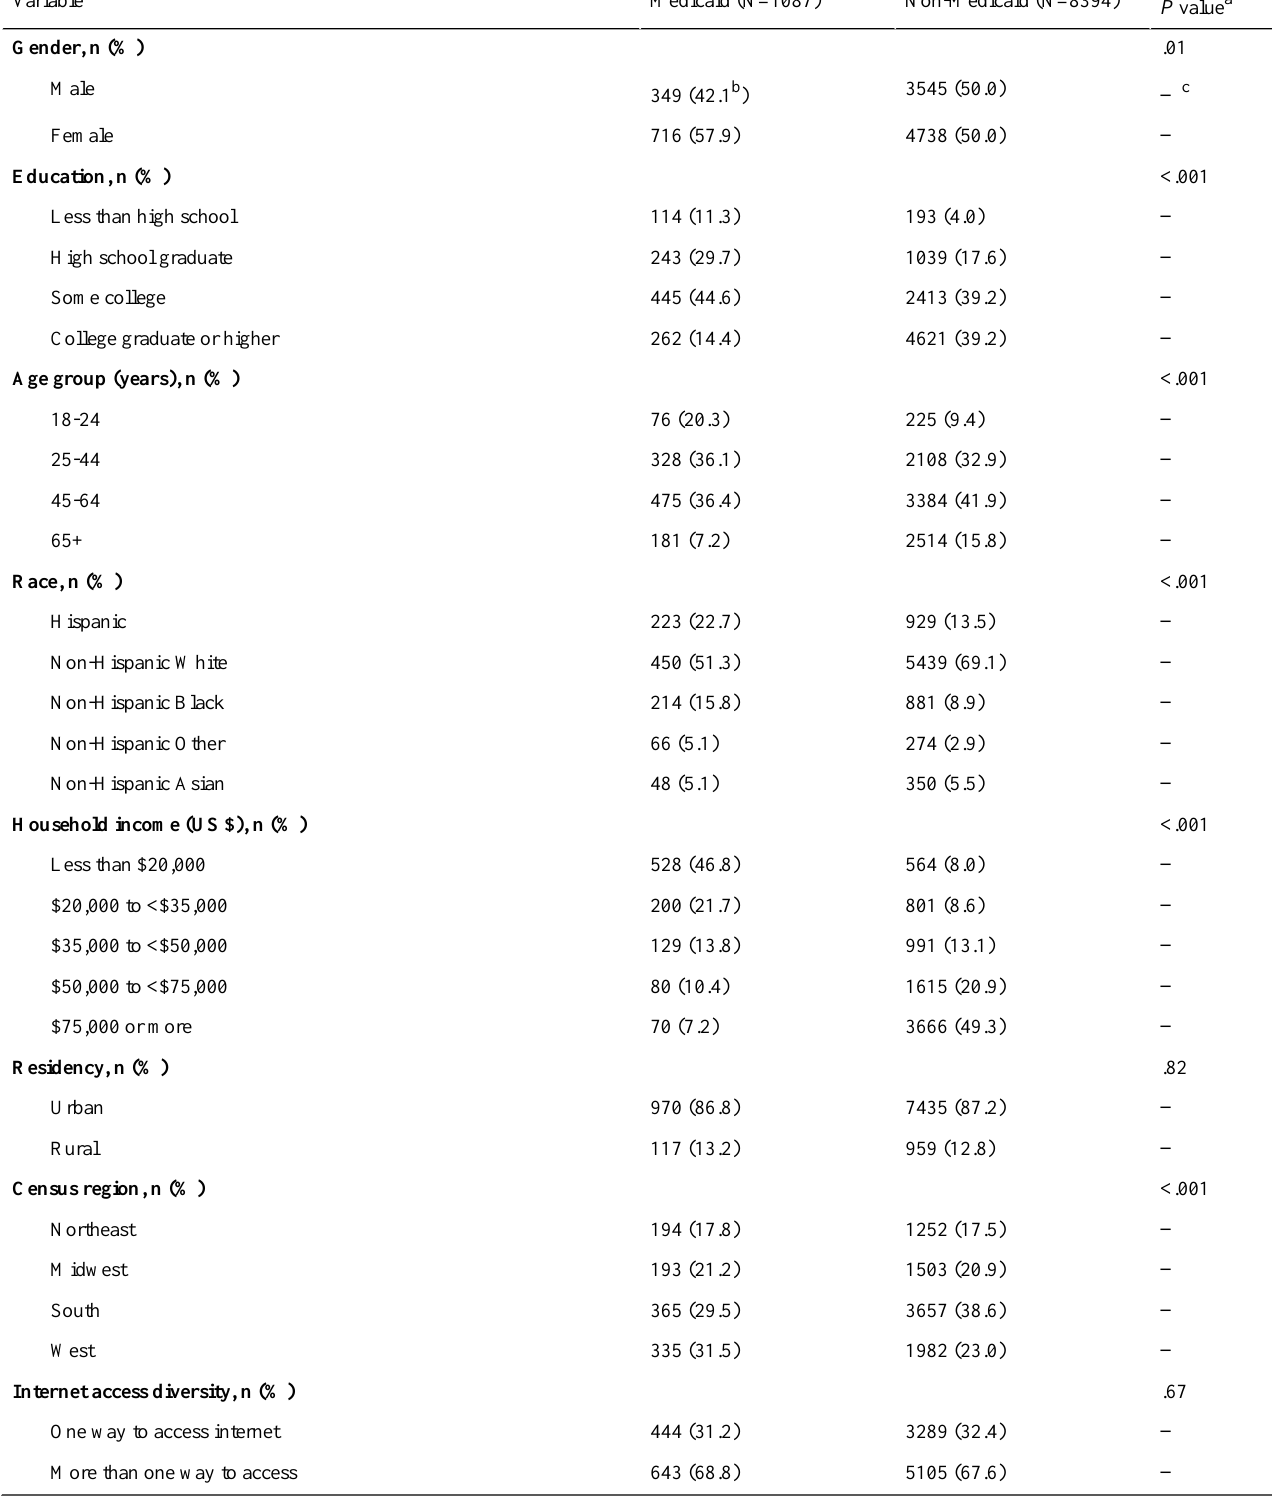
Table 1. Demographic characteristics of sample from 3 iterations, 2017-2019, by Medicaid insurance